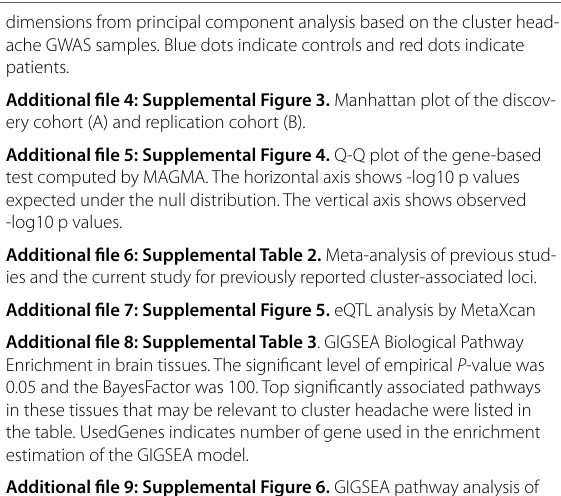
Additional file 7: Supplemental Figure 5. eQTL analysis by